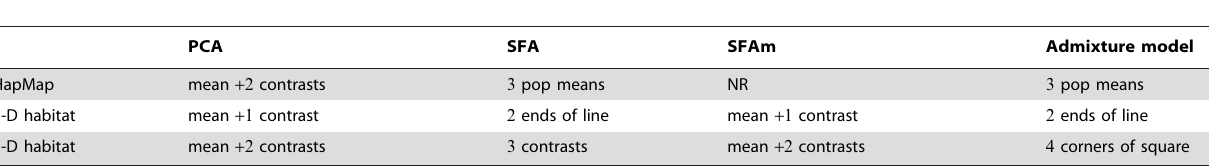
Table 2. Summary of results across PCA, SFA, and admixture-based models.